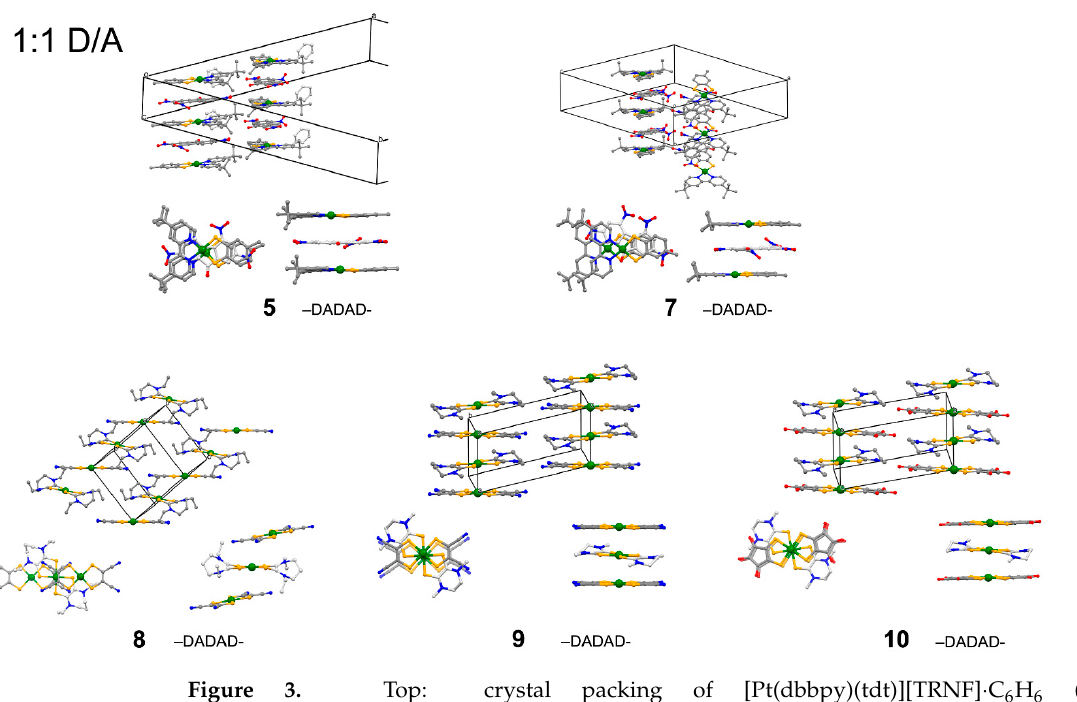
Figure 3. Top: crystal packing of [Pt(dbbpy)(tdt)][TRNF] · C 6 H 6 ( 5 ) and [Pt(dbbpy)(tdt)][TENF] · 0.5C 6 H 6 ( 7 ) [11]. Bottom: crystal packing of [Pt(Et 2 dazdt) 2 ][Pt(mnt) 2 ] ( 8 ) [22], [Pt(Me 2 pipdt) 2 ][Pt(mnt) 2 ] ( 9 ) [23] and [Pt(Me 2 pipdt) 2 ][Pt(dtcr) 2 ] ( 10 ) [24]. All systems exhibit a columnar stack with a -DADAD- pattern. Two columnar stacks are depicted in the